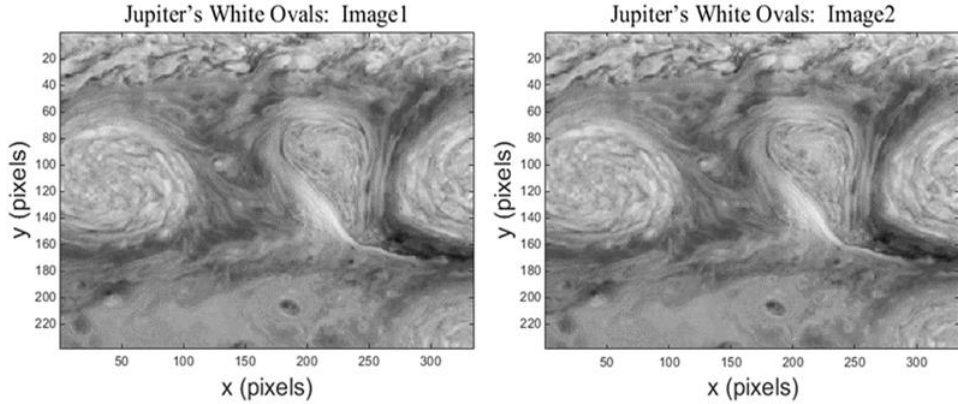
Figure 15. An image pair of Jupiter’s White Ovals.